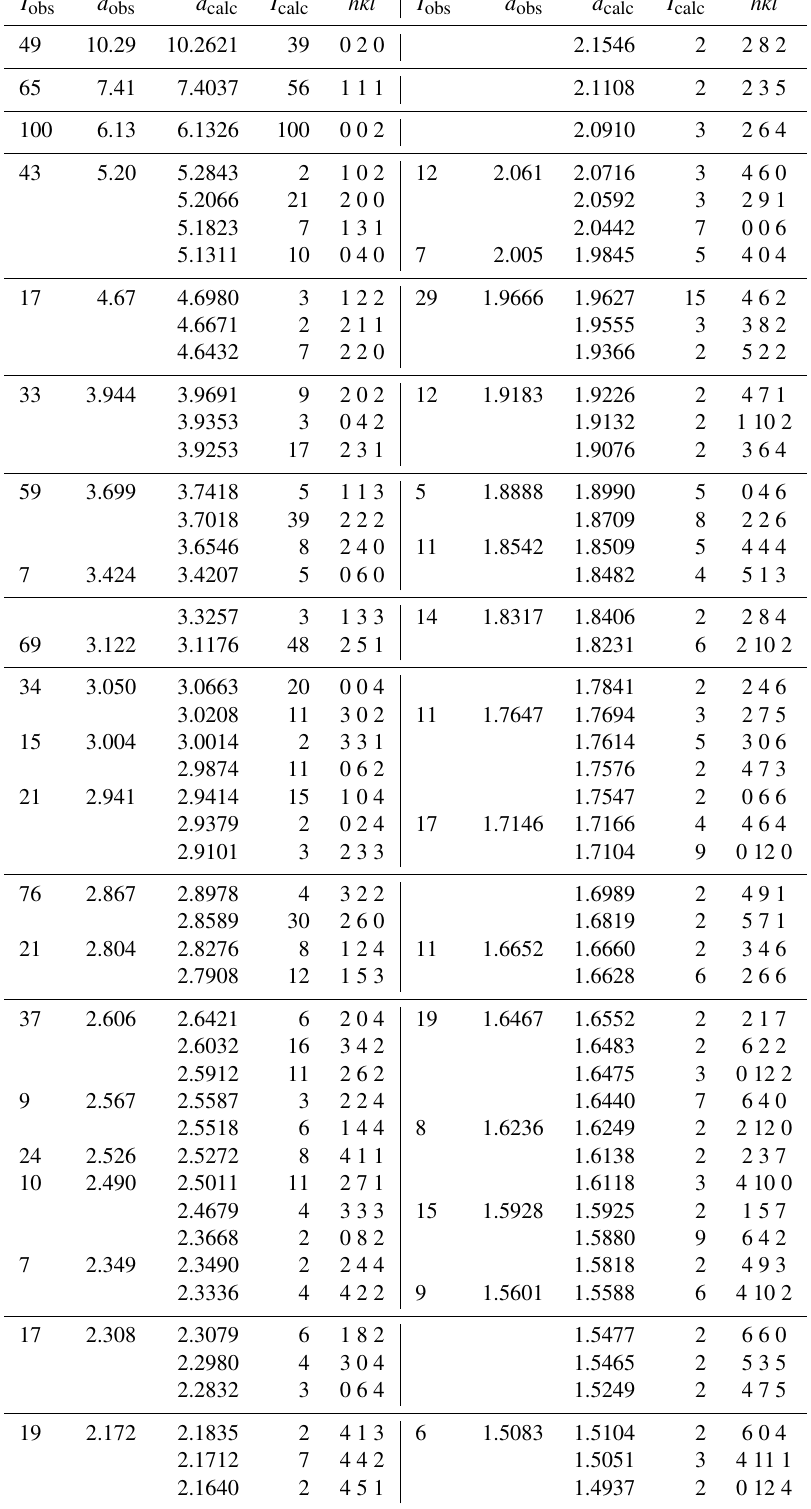
Table 2. Powder X-ray diffraction data ( d in Å) for pleysteinite ( I calc >